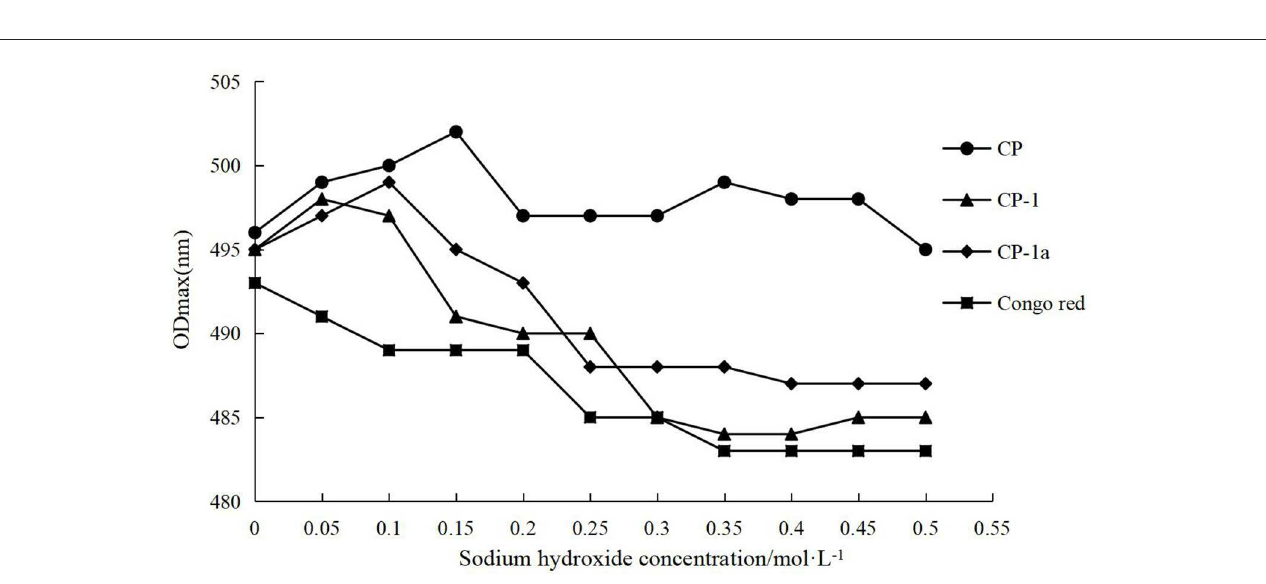
FIGURE7 Triple helix conformation analysis of CP, CP-1, CP-1a, and Congo